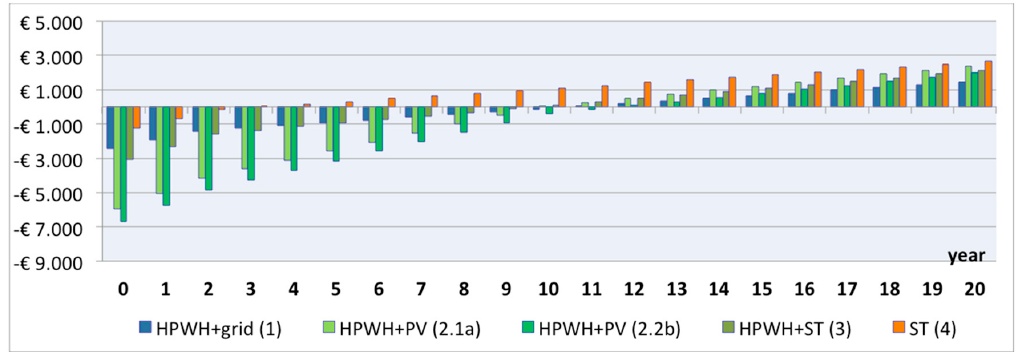
Figure 20. Cash flow and net present value of selected solutions (with national incentive).